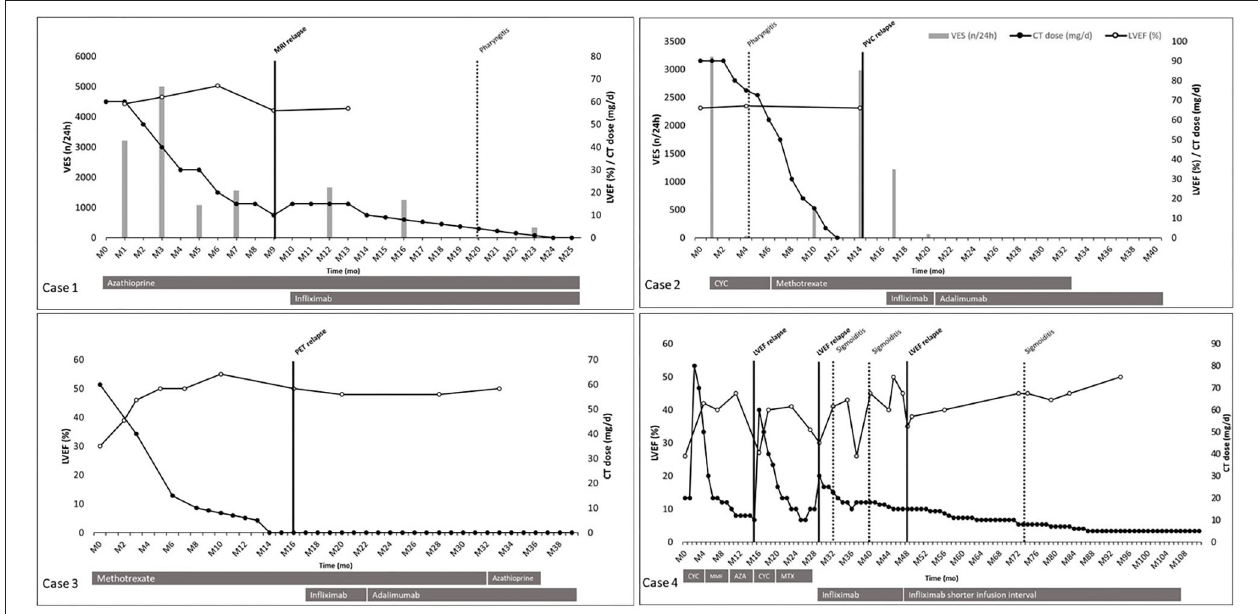
FIGURE 1 | Patients’ follow-up outcomes. Individual case presented from diagnosis (MO) to the end of follow-up for the study. Time in month on abscissa. Prednisone dose (mg/d), left ventricular ejection fraction (%), number of ventricular extrasystole (n/24h) on Ordinate. Used therapies are represented in gray bars below each timeline. Black dots correspond to prednisone dose (mg/d). White dots correspond to left ventricular ejection fraction (%). Vertical gray bars correspond to number of ventricular extrasystole (n/24h). Vertical black bars correspond to relapse. Vertical black dotted line corresponds to adverse events. Case 1: azathioprine was used 150 mg/d; infliximab was used 5 mg/kg at week 0 and 2, and every 4 weeks. Case 2: cyclophosphamide was used 1,000 mg/mo; methotrexate was used 15–20 mg/w; infliximab was used 5 mg/kg at week 0 and 2, and every 4 weeks; adalimumab was used 40mg every 2 weeks, subcutaneously. Case 3: methotrexate was used 10–15 mg/w; azathioprine was used 100 mg/w; infliximab was used 5 mg/kg at week 0 and 2, and every 4 weeks; adalimumab was used 40mg every 2 weeks, subcutaneously. Case 4: cyclophosphamide was used 1,000 mg/mo; mycophenolate mofetil was used 720 mg/d; azathioprine was used 150 mg/d; methotrexate was used 10–15 mg/w; infliximab was used 3 mg/kg at week 0 and 2, and every 8 weeks, then 5 mg/kg every 6 weeks. AZA, azathioprine; CI, corticosteroid therapy; CYC, cyclophosphamide; LVEF, left ventricular ejection fraction; MMF, mycophenolate mofetil; MRI, magnetic resonance imaging; MIX, methotrexate; PET, positron emission tomography; PVC, pre-mature ventricular contraction; VES, ventricular